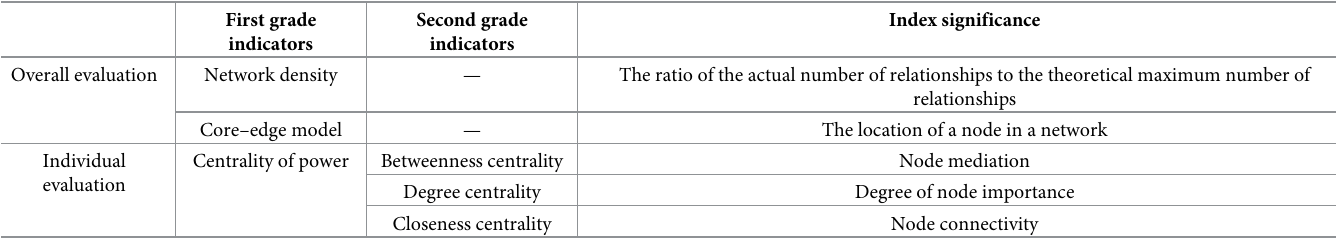
Table 1. Tourism network structure evaluation indicators and their